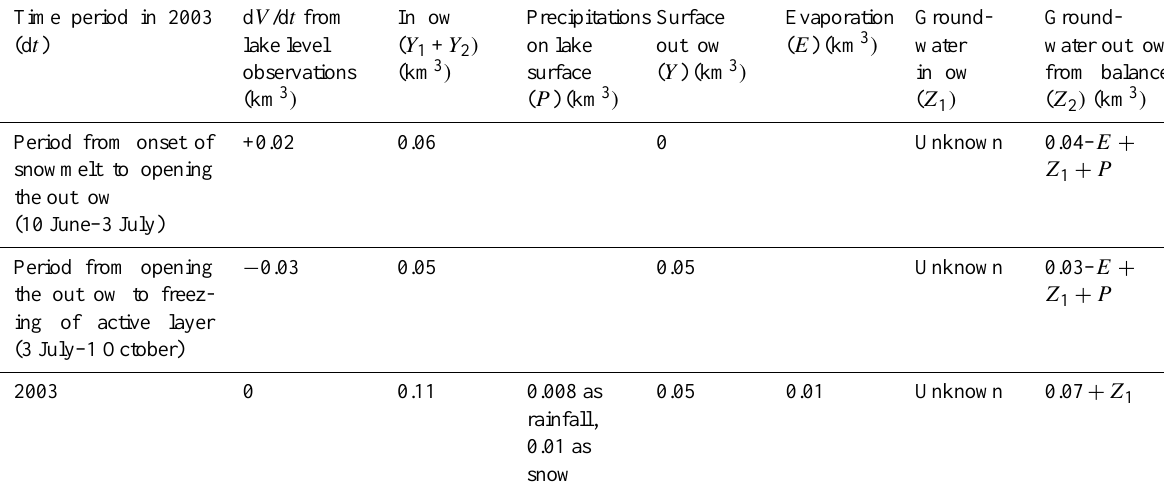
Table 2. Lake El’gygytgyn water balance components in 2003.